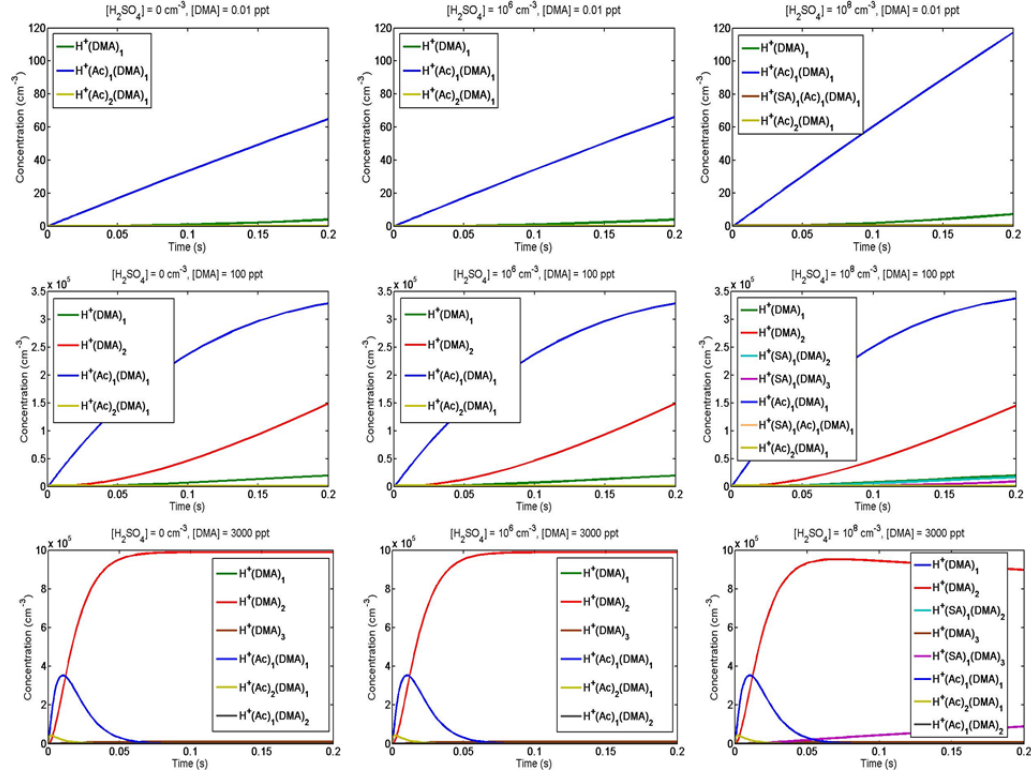
Figure 2. Modelled concentrations during chemical ionization. The columns are ordered from left to right by increasing sulfuric acid con- centration, and the rows are ordered from top to bottom by increasing dimethylamine concentration. The temperature is 298.15K in all subplots.